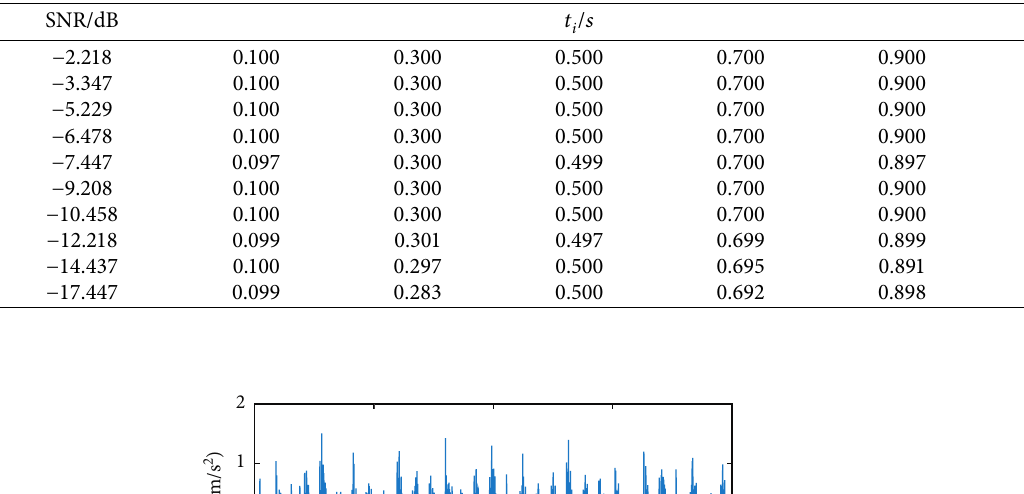
Table 2: The analysis results the simulated signal with the proposed method at different SNR.